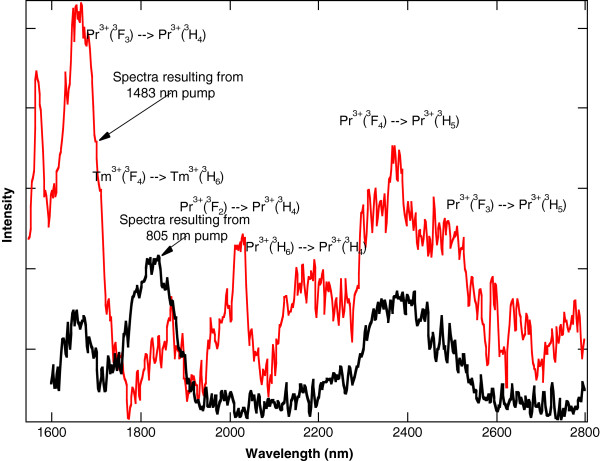
Fluorescence from 1,600 to 2,800 nm from Tm3+-Pr3+:KPb2Cl5. Fluorescence resulting from 1,483-nm pumping of Tm3+-Pr3+:KPb2Cl5 compared to fluorescence resulting from 805-nm pumping. The sample has a Pr3+ concentration of 1.5 × 1020 ions/cm3 and a Tm3+ concentration of 3.0 × 1020 ions/cm3.